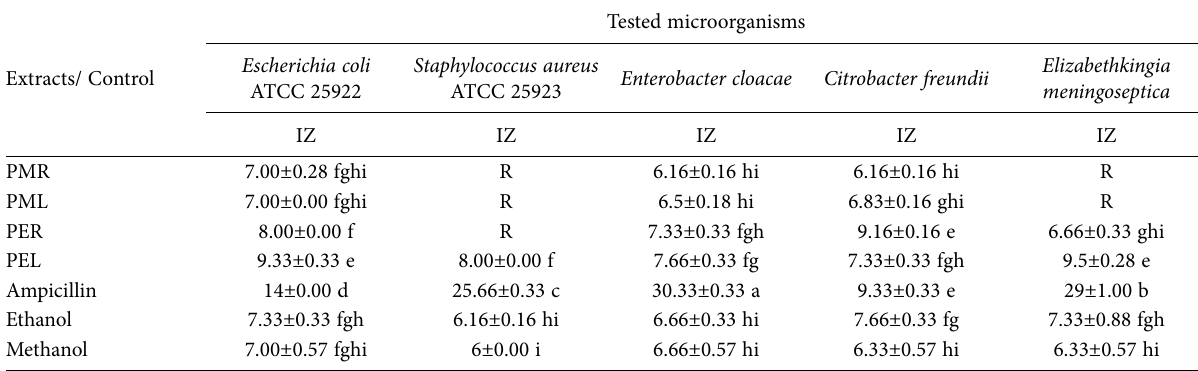
Table 2. Antimicrobial activity of the extracts of leaves and rhizomes of Polystichum setiferum (Forssk.) Moore ex Woyn. (inhibition zone – in